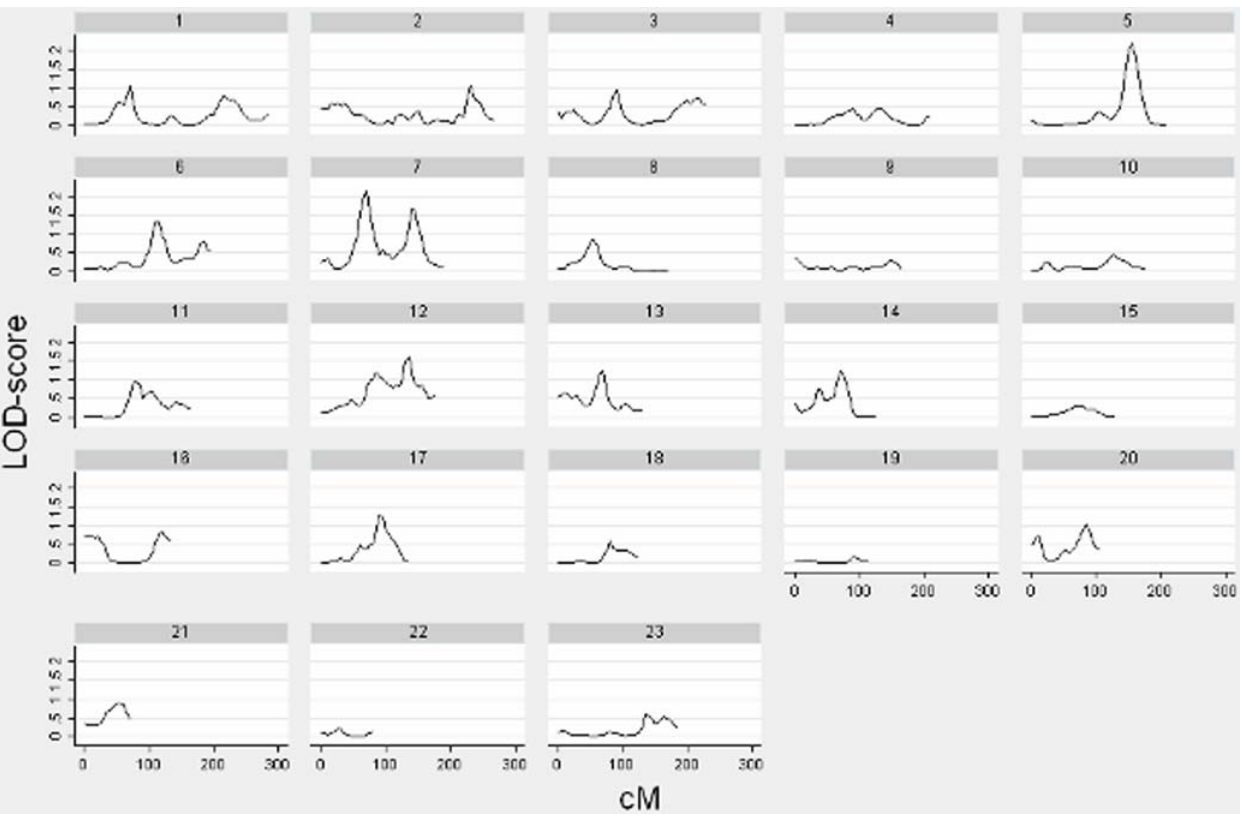
Figure 2. Linkage Results (LOD-score vs. cM) for Femur Length. LOD-scores are illustrated for chromosomes 1–23 for femur length. There is one suggestive peak (LOD = 2.19) on chromosome 5.